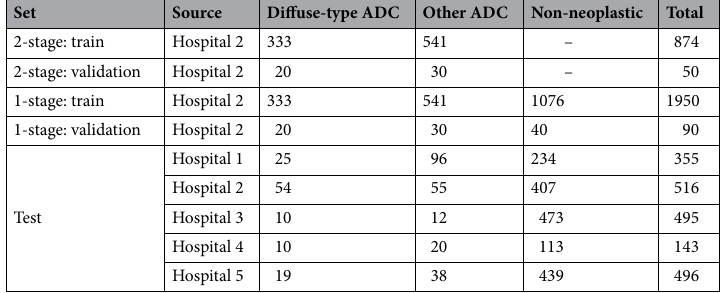
Table 3. Distribution of WSIs in the training, validation, and test